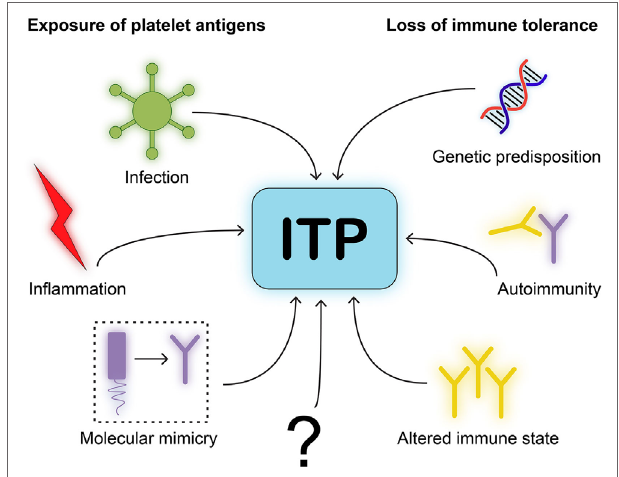
FiGURe 3 | Model for immune thrombocytopenia (ITP) pathogenesis. We postulate a simplified model for the pathogenesis of ITP. One, neo-epitopes on platelet antigens need to be exposed to immune cells. This requires an initiating event or trigger, such as infection, inflammation, or molecular mimicry of viral antigens to resemble platelet glycoproteins. Two, immune cells will need to be able to develop self-reactivity due to loss of immune tolerance. This requires either genetic disposition in immune related-genes, autoimmunity by comorbidities that implies a central dysfunction in tolerance, or an altered immune state such as after organ